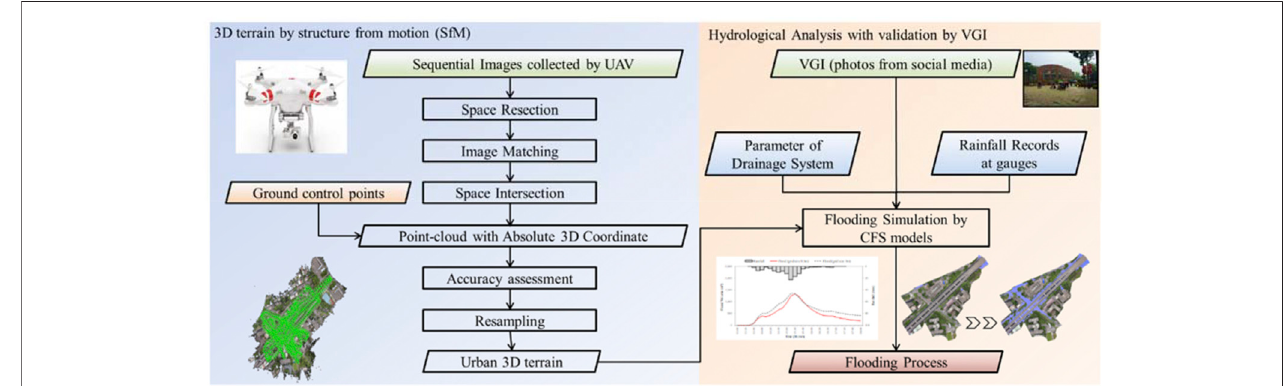
FIGURE 4 | Illustration of collinearity condition and space intersection (adapted from Lillesand and Kiefer, 1999).